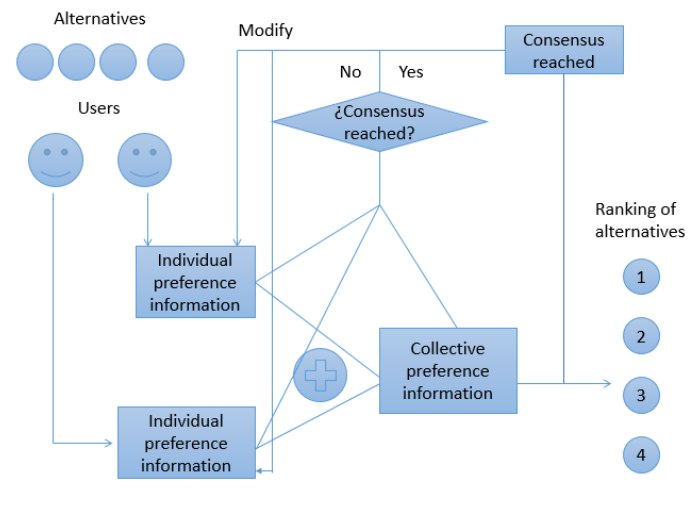
Figure 2. Group Decision Making general scheme.